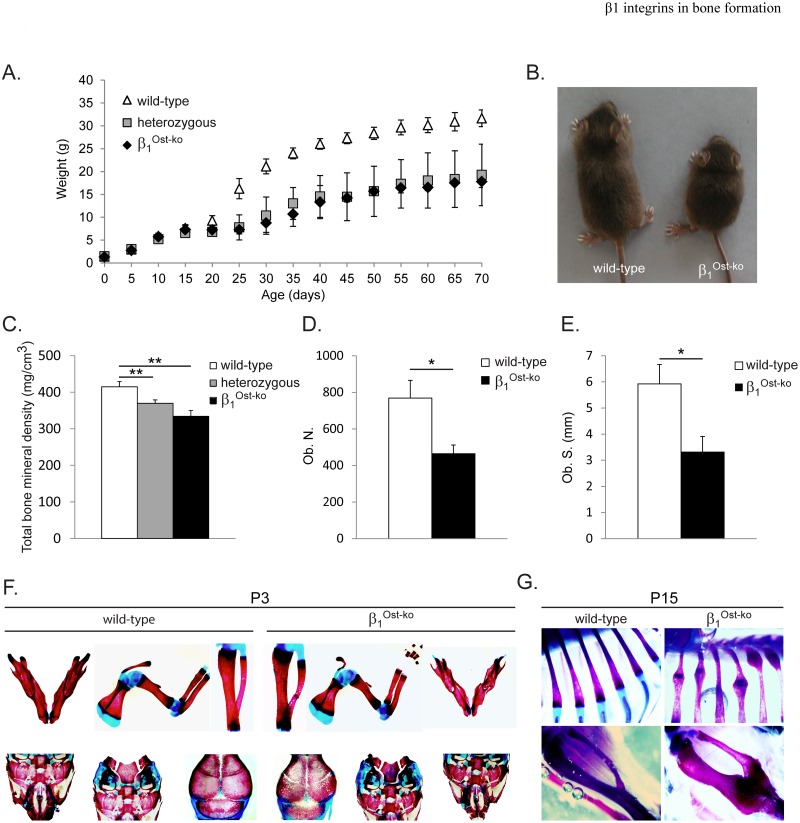
β1 integrin deletion at pre-osteoblastic stage leads to severe bone phenotype.A. Growth curve of wild-type, heterozygous and β1 integrin deleted (β1Ost-ko) mice. B. Picture of wild-type and β1Ost-ko mice showing the growth defect due to β1 integrin deletion at pre-osteoblastic stage. C. Total bone mineral density (BMD) of wild-type, heterozygous and mutant mice measured using micro Computed Tomography (**: p<0.005). D and E. Histomorphometric analysis of osteoblast number (Ob. N.) D. and surface (Ob. S.) E. at P30 depending on mice genotype (*: p<0.05). F and G. Alizarin Red and Alcian Blue staining of skeleton from 3-days or 15-days old wild-type and β1Ost-ko mice. Note the increased porosity of skull, jaw and long bones, as well as bending and hypertrophic callus resulting from former fractures in β1Ost-ko mice.